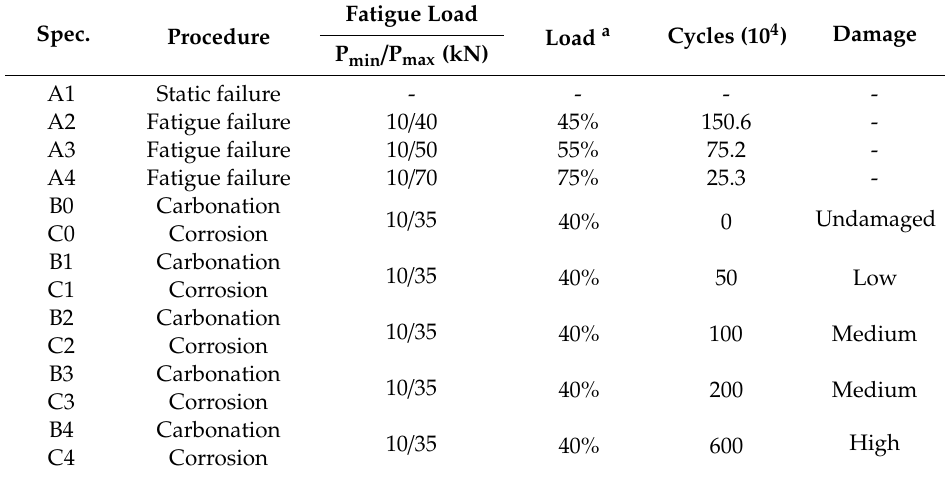
Table 1. Summary of the specimens and loading conditions.